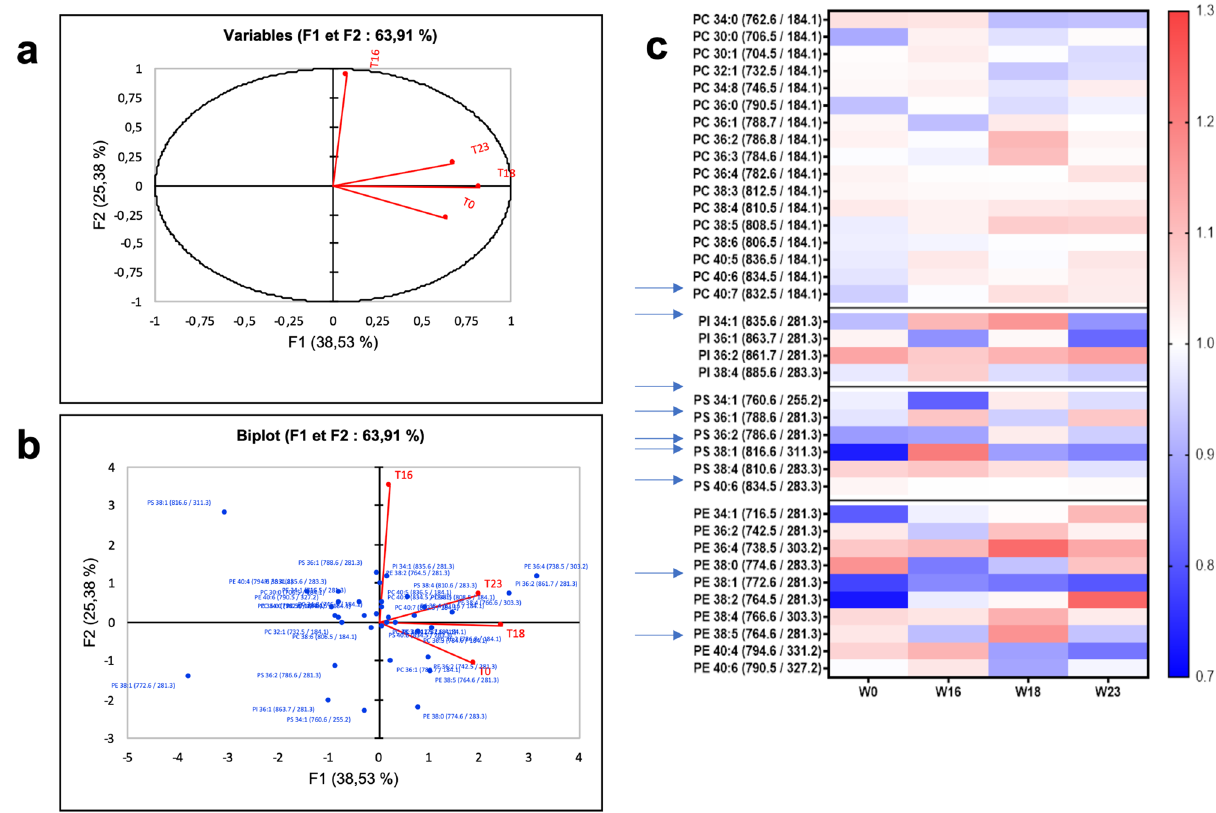
Figure 3. (a) Loading plot of principal component analysis of variables with F1 representing 38.53% of variabiliting and F2 25.38% based on the LC–MS–MS analysis in positive and negative mode of 24 mice (12 under high-fta diet and 12 control) at four stages (T0, T16, T18 and T22w). (b) PCA score plot of log ratio (obese/chow) using XLSTAT software (Addinsoft 2020. XLSTAT statistical and data analysis solution. New York, USA). (c) Heat map analysis of obese/control ratio based on the LCMS–MS quantification of phospholipids showed significantly modified lipids intensity over time (Graph Pad Prism